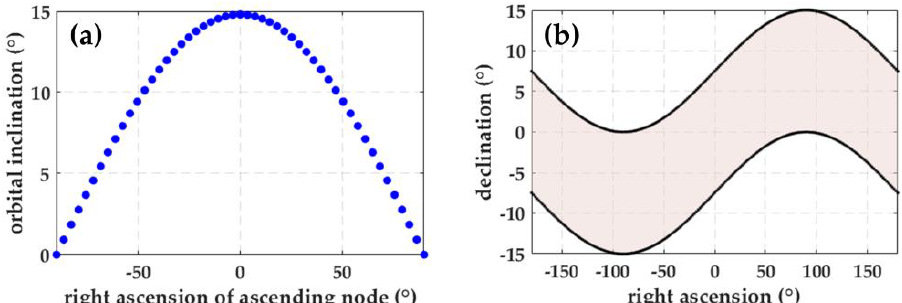
Figure 2. ( a ) The relationship between RAAN and inclination. ( b ) Theoretical distribution of GEO objects beyond control.